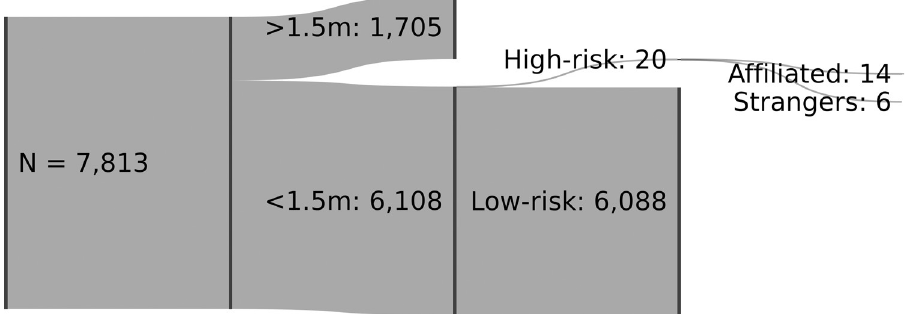
Fig 1. Descriptive breakdown of the observed person’s involvement in risk